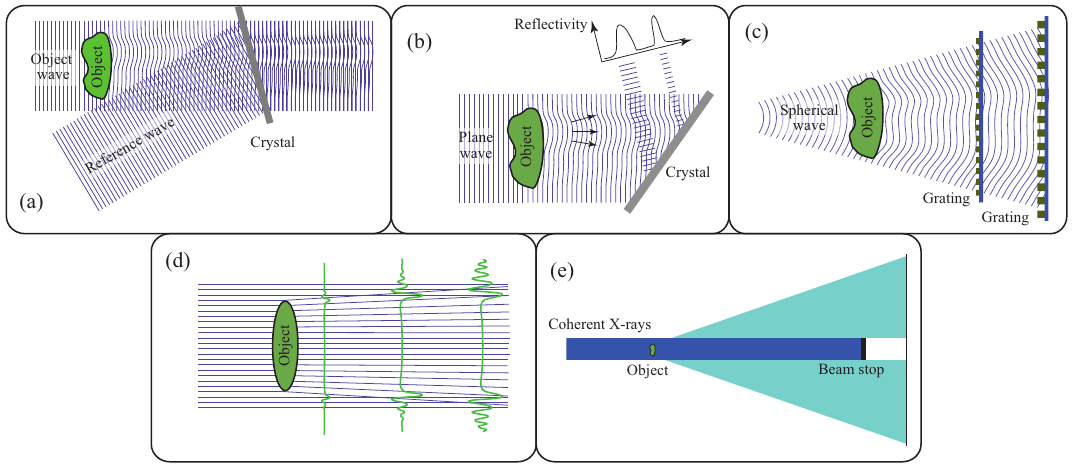
Figure 2. Techniques developed to generate X-ray phase contrast: ( a ) Two-beam interferometry, ( b ) diffraction-enhanced imaging, ( c ) grating interferometry, ( d ) propagation-based method, ( e ) coherent diffraction